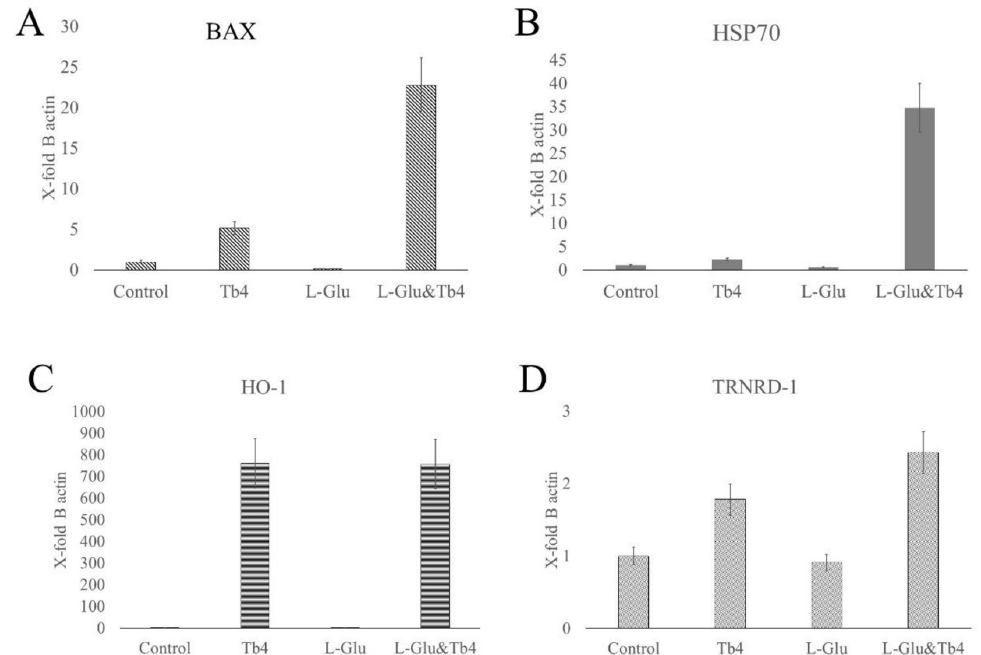
Figure 6. mRNA expression levels (mean and standard error) of ( A ) BAX, ( B ) HSP70 ( C ) HO-1, and ( D ) TRNRD-1, which are related to stress conditions, in J774 cells. The amount of mRNA of each gene for each experiment was normalized with the respective value of the beta-actin housekeeping gene mRNA (X-fold of beta-actin expression). Statistical comparison of the gene’s expression in different experimental conditions was performed with 5.0 GraphPad Prism software. The data were also analyzed with one-way ANOVA. p values < 0.05 was considered